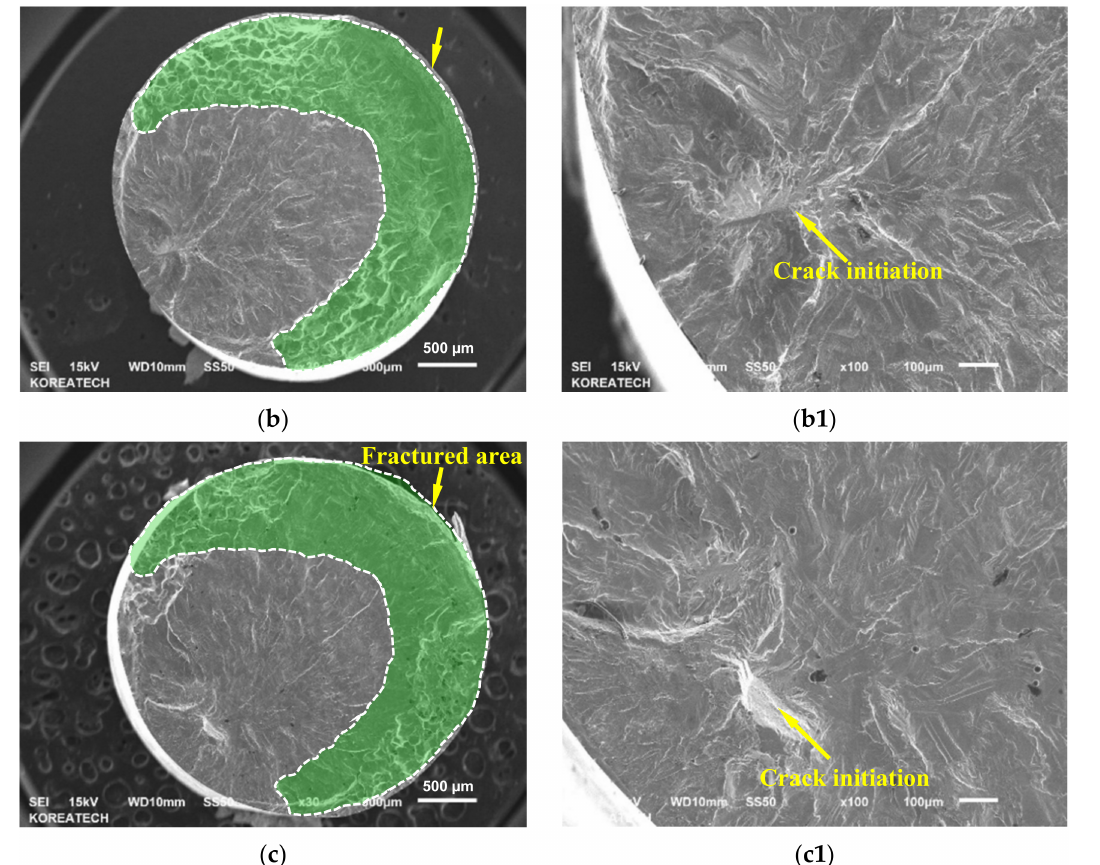
Figure 9. Comparison in fatigue fracture surface of the untreated ( a , a1 ), UNSM-treated at RT ( b , b1 ) and UNSM-treated at HT ( c , c1 )